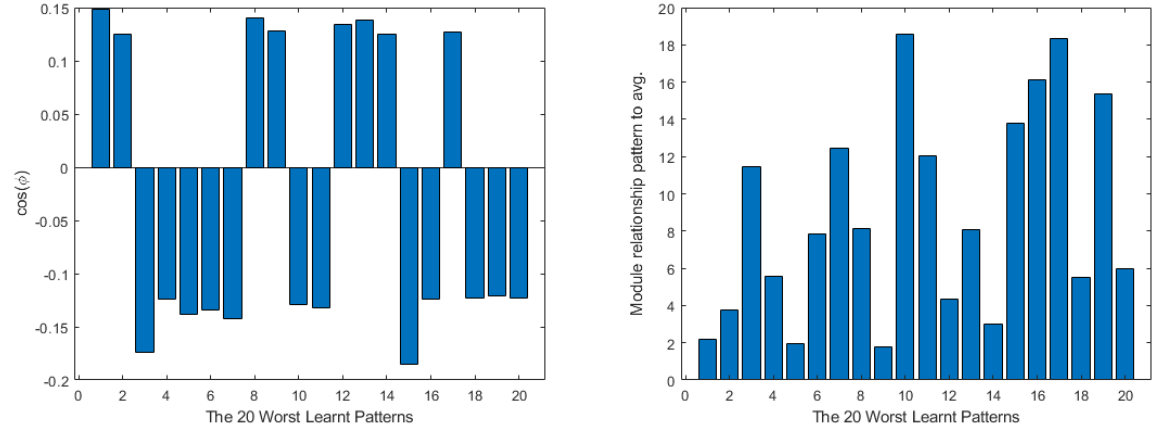
Figure 33. Unified best learned patterns cos(φ) on the ( left ) and | 𝜕𝐿𝑜𝑠𝑠 | on the ( right ) for the Goldstein Prize function using the standard SGD algorithm. 𝜕𝑊 𝑛